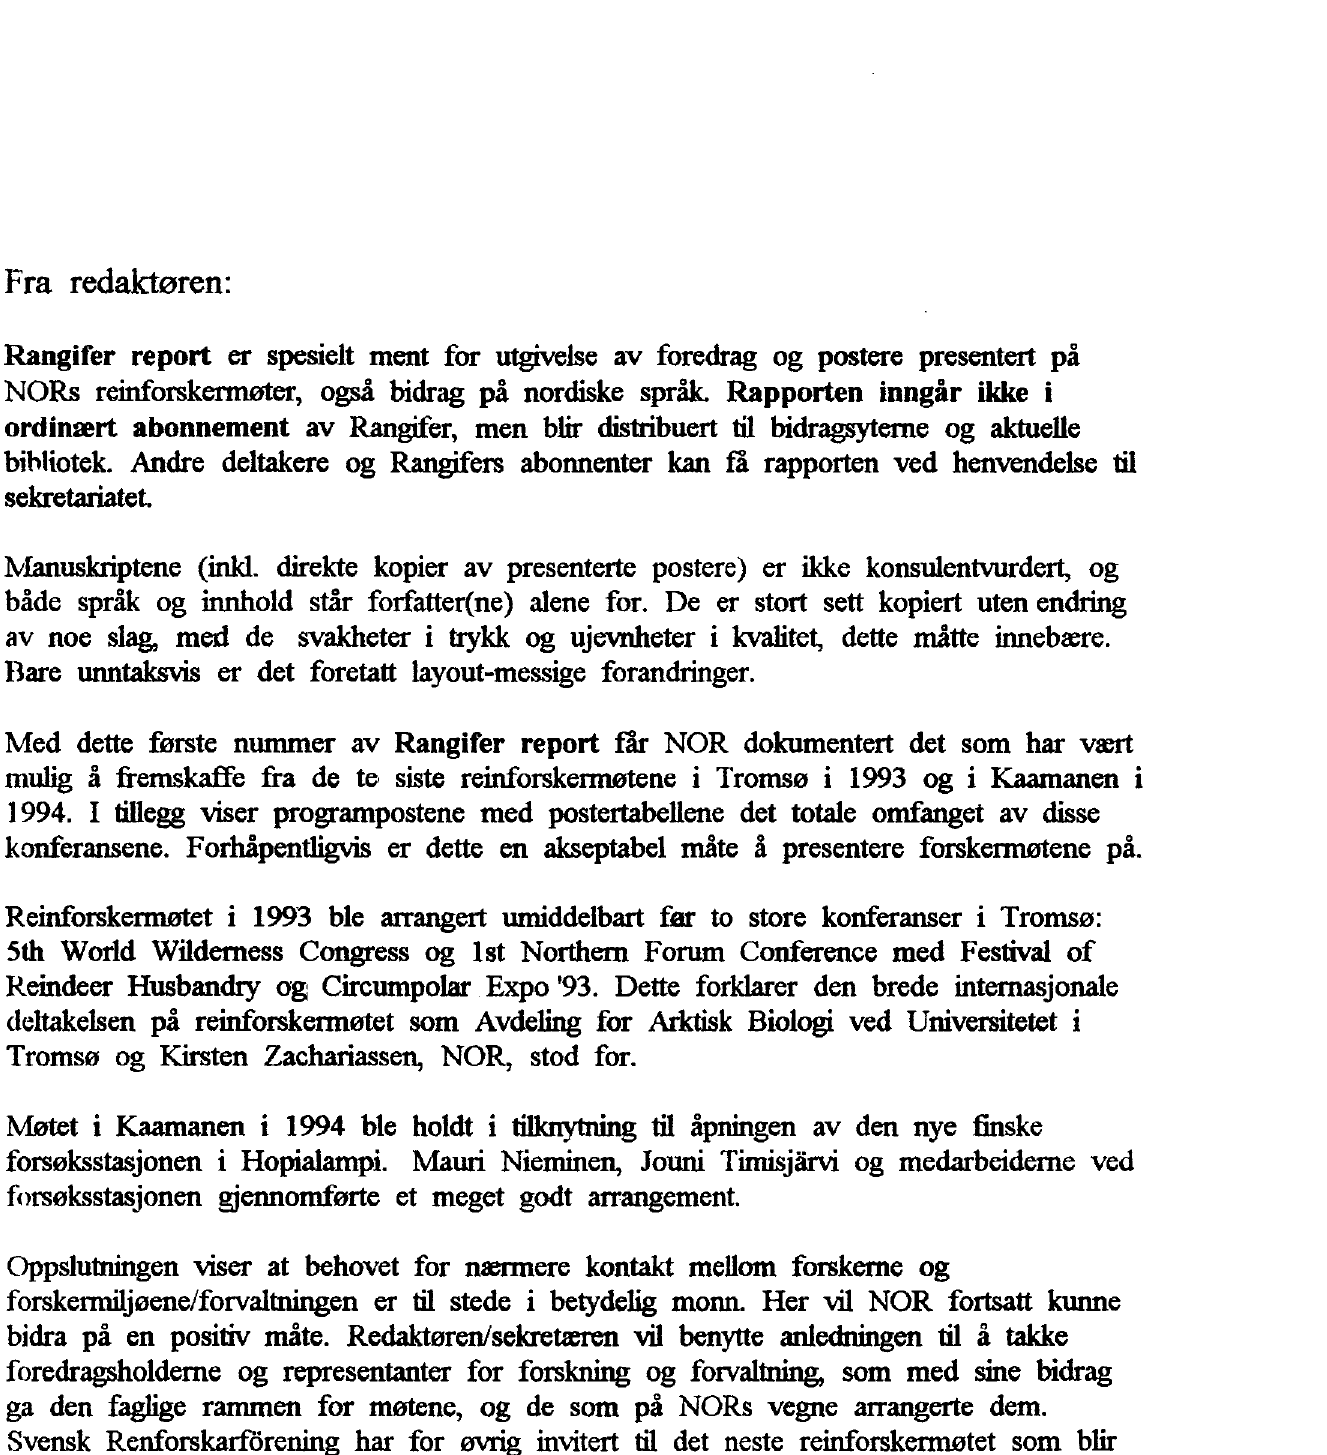
Tromsø 31. mars 1995